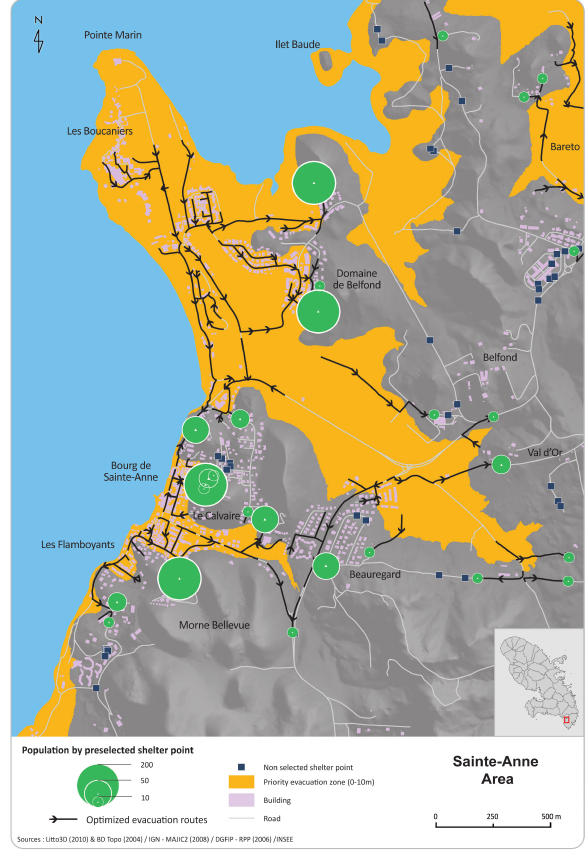
Fig. 5. Automatic preselection of safe sites (20m high shelter) and optimal evacuation routes for populated areas (e.g. Sainte-Anne mu-